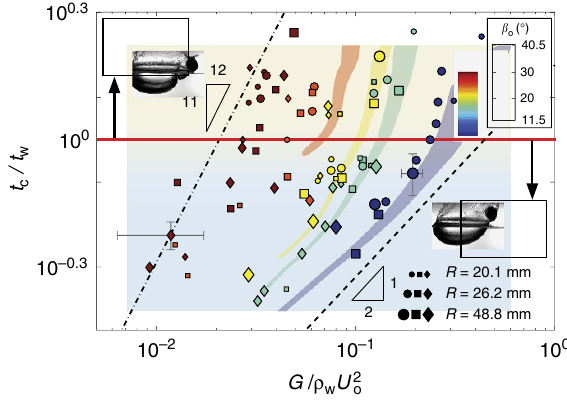
Figure 5 | Matryoshka cavities depend on two timescales. When conditions produce impacts in which the collision time t c is longer than the elastic wave propagation time t w (that is, t c / t w 4 1) matryoshka cavities form. Figure 6 | Classification of impact phenomena for single and multiple and b o , with Experiments show that the timescale ratio depends on G = r w U 2 o skip events. Experiments show that all vibration modes and accompanying seemingly minimal dependence on R (marker size indicates R ; marker shapes skipping behaviour are classified by the ratio of material stiffness to indicate same G as for Fig. 3b). The four coloured patches result from (cid:3) (cid:4) and b þ ; crosses: hydrodynamic pressure G = r w U 2 calculations using our analytical model with the same material properties as o (triangles: mode 1 o mode 2; black circles: mode 1 (cid:2) skipping; grey circles: mode 1 (cid:2) transitional; for the experiments. Varying R in the model over the range experimentally x-marks: water entry). The experimental data shown are for all three elastic tested results in the spread in the patches, which is small for t c / t w o 1. For sphere radii. The coloured regions provide a visual boundary of the skipping (cid:3) (cid:4) 1 = 2 shallow impact angles, scaling analysis predicts t c = t w / G = r w U 2 o (blue), transitional (yellow) and entry (red) regimes. Our analytical model (cid:3) (cid:4) 11 = 12 (dashed line), while for steep impact angles we expect t c = t w / G = r w U 2 accurately predicts the boundary between mode 1 (cid:2) skipping and o (dash-dot line). These limiting trends capture the general evolution shown by transitional events; the red line is found from the intersection of the the experimental data. Characteristic error bars are analytical results with t c / t w ¼ 1 in Fig. 5. Given initial conditions of the first skip, our analytical model also predicts successive impact types in a multiple skip trajectory (blue squares). A multiple skip experiment validates these predictions within the limits of our test facility (purple markers; , R ¼ 26.2mm, G ¼ 12.3kPa, r * ¼ 0.937). Images from the multiple skip which is confirmed experimentally (Supplementary Fig. 2). experiment are shown in Fig. 8. Characteristic error bars are shown in grey. (cid:4) 1 = 2 = l max . We can now examine the evolution of the timescale ratio in the vicinity of the transitional regime in the limit of shallow ( b o - 0) and steep impact angles, making use of U 2 shown in Fig. 3c. the relationship between l max and G = r w o